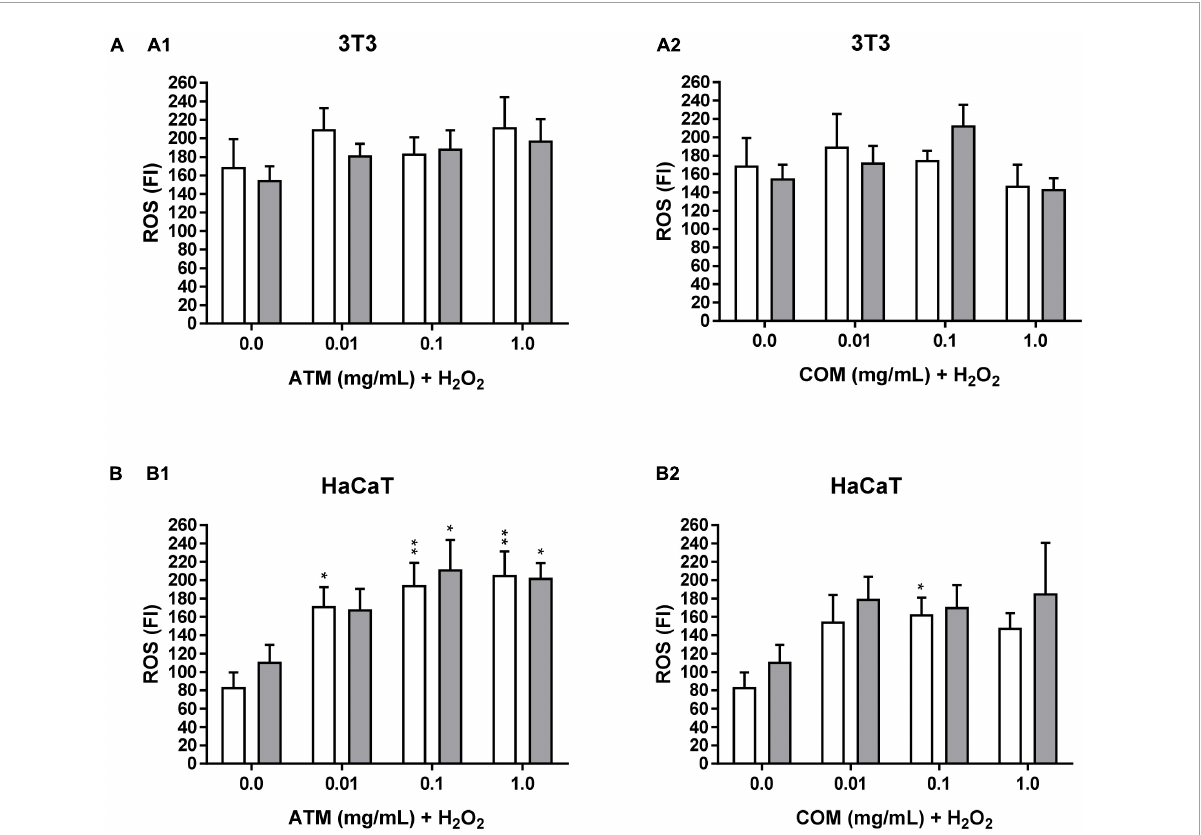
FIGURE5 Intracellular ROS induced by 1 and 2 mM H 2 O 2 for 2 h treatment with ATM (1) and COM (2) in 3T3 ( A) and HaCaT (B) cells H 2 O 2 cell viability was used as a positive control. White columns correspond to 1 mM H 2 O 2 , and gray columns correspond to 2 mM H 2 O 2 . Results are expressed as mean ± standard error of n = 3. A two-way analysis of variance (ANOVA) and a Bonferroni post hoc assay have been performed. Statistical differences were considered as follows: * p ≤ 0.05 and ** p ≤ 0.01 comparison with the corresponding positive